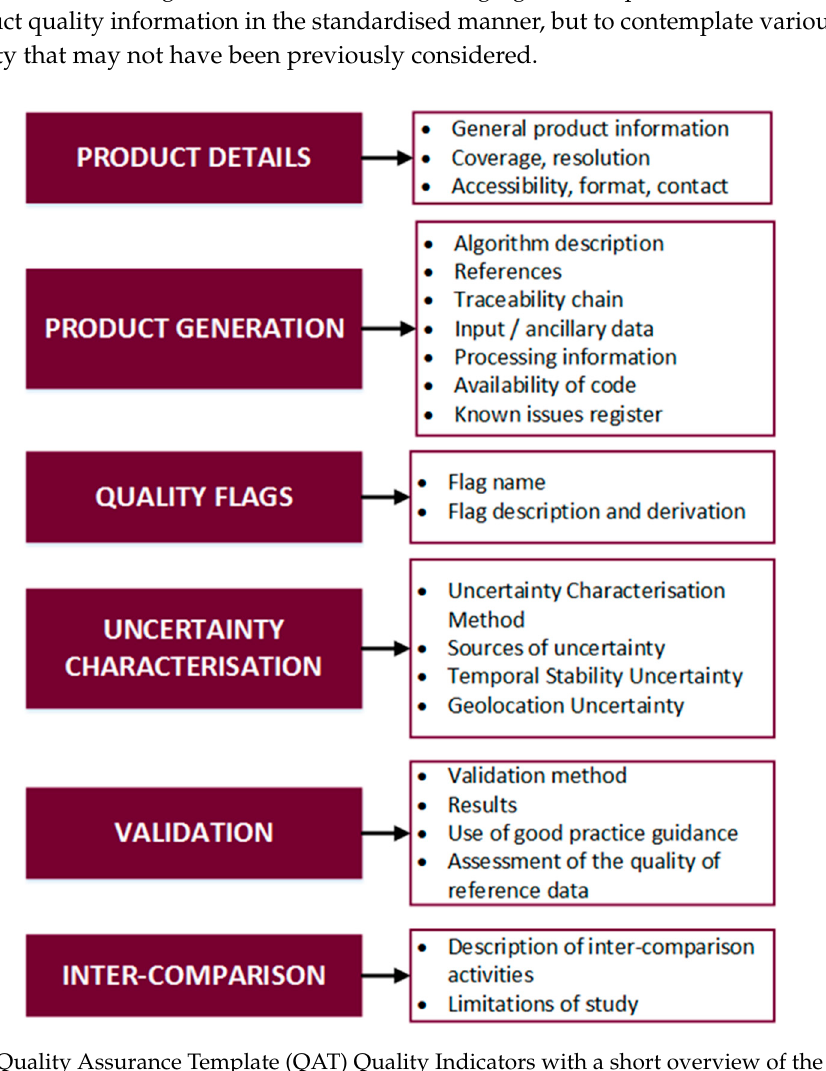
Figure 1. Quality Assurance Template (QAT) Quality Indicators with a short overview of the type of information collated within each section.